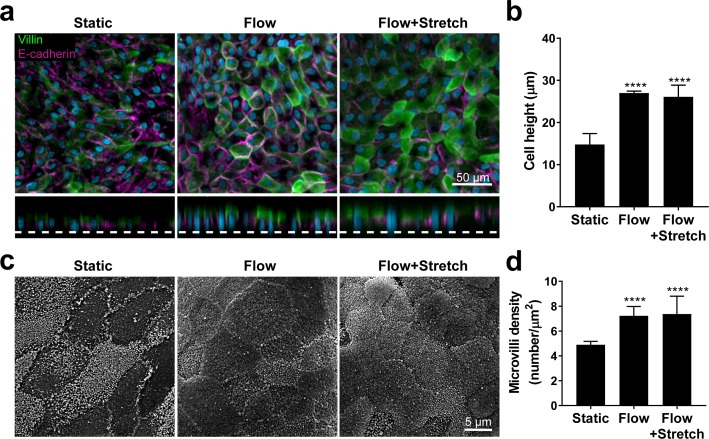
Flow-induced increase in primary intestinal epithelial cells height and microvilli formation.(a) Representative confocal images of x-y (top) and x-z (bottom) optical sections of duodenal organoid-derived epithelial cells cultured for 72 hr under static (Static), fluid flow (30 µl/hr; Flow) or flow and stretch (30 µl/hr; 10% strain, 0.2 Hz; Flow+Stretch) conditions and stained for apical marker villin (green) and basolateral protein E-cadherin (magenta). Nuclei were counterstained with DAPI (gray). Scale bar, 50 µm. (b) Quantitative analysis of the average cell height measured from Z-stack images as the distance between apical marker villin (green) and PDMS membrane (dotted line). Data represent the mean ± s.e.m; One-way ANOVA, ****p<0.0001. (c) Scanning electron microscopy surface images of duodenal organoid-derived epithelium cultured for 72 hr under static or ﬂow +/- stretch conditions. Cells seeded in the top channel of Intestine-Chip were maintained with (Flow) or without (Static) medium perfusion (30 µl/hr) in both channels and 10% of mechanical stretch (0.2 Hz) (Flow+Stretch). Images were captured at the center area of the chamber. Scale bar, 5 µm. (d) Quantiﬁcation of microvilli. Density of microvilli per µm2 was measured from the SEM images (100 µm2, 20 FOV) as described in the Materials and methods. Data represent the mean ± s.e.m; one-way ANOVA, ****p<0.0001.